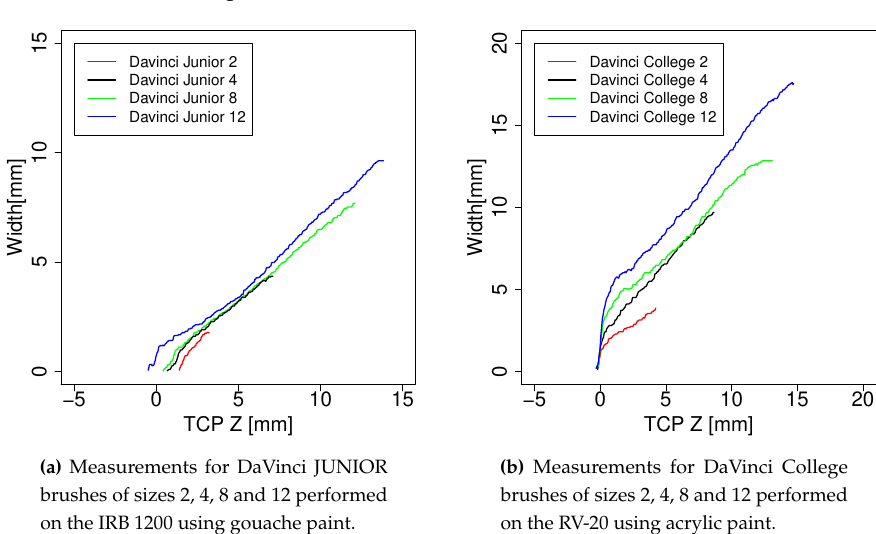
Figure 6. Pressure/Width calibration of a brush.